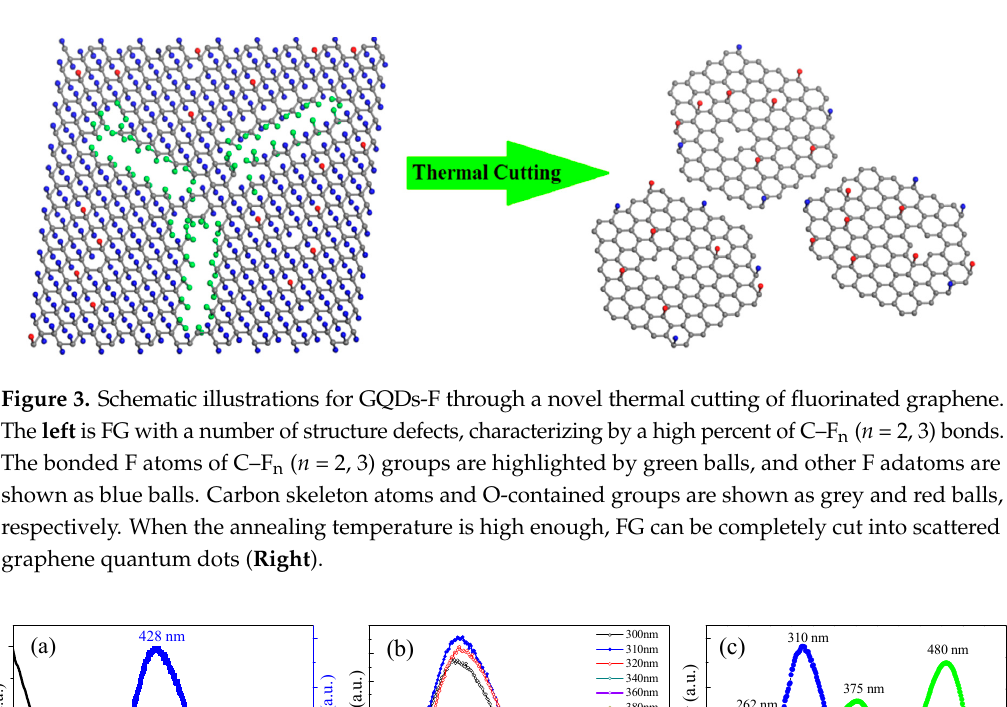
Figure 4. ( a ) The left curve is UV-vis absorption of the GQDs-F sample dispersed in water. The right curve is the emission spectrum of GQDs-F under 310 nm excitation. ( b ) The PL spectra of the GQDs- F at different excitation wavelengths. ( c ) The PLE spectrum of the GQDs-F with the detection wavelength of 428 nm (the blue curve) and 533 nm (the green curve).